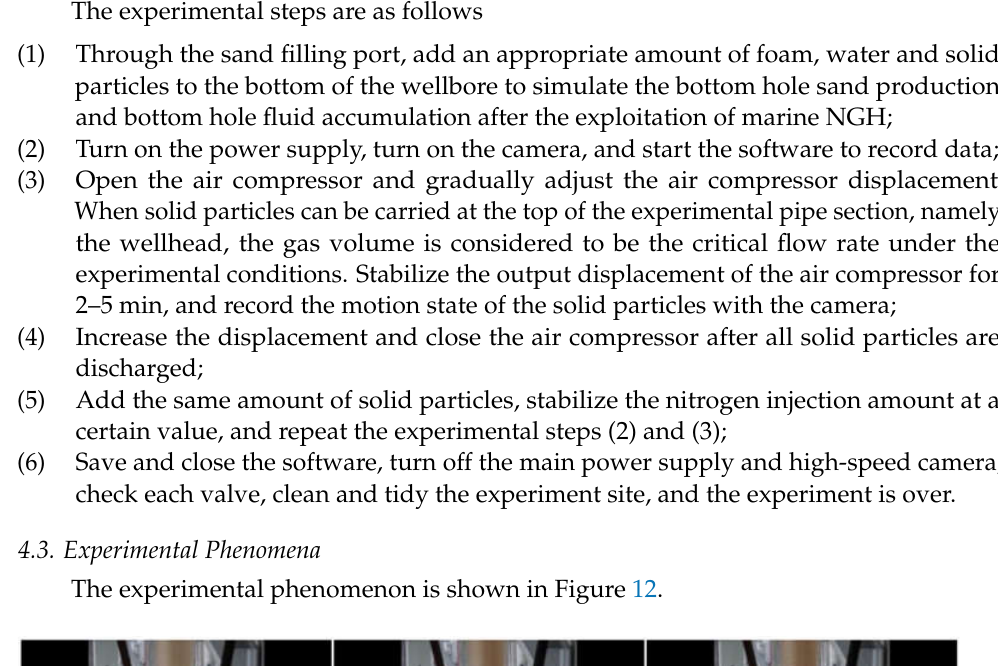
Figure 11. Foam for experiment.